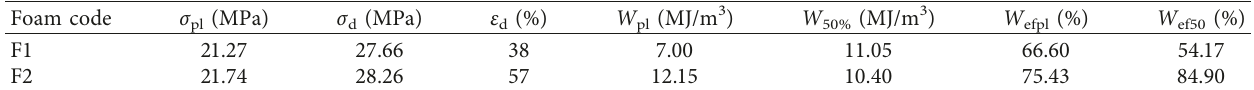
Figure 4: (a) Compressive stress-strain curves and (b) energy absorption vs. nominal strain for two kinds of Al foams (F1 and F2) of comparable relative density ρ / ρ s ≈ Table 3: Summary of mechanical parameters for Al foams under compression.